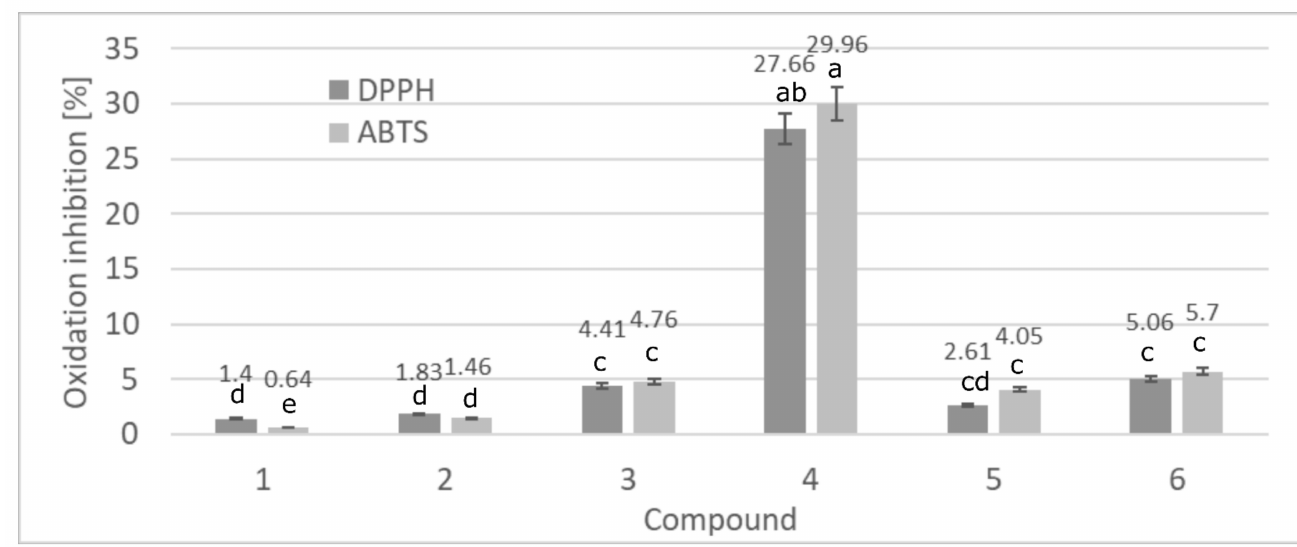
Figure 2. The total antioxidant activity the tested triterpenes using DPPH and ABTS methods. Numbers refer to compounds found in Figure 1 (1: lupeol, 2: lupeol acetate, 3: lupeol propionate, 4: lupeol isonicotinate, 5: lupeol succinate, 6: lupeol acetylsalicylate). Data presented as mean values ± SD ( n = 3). Different letters (a–e) indicate significant difference between mean values at p < 0.001.